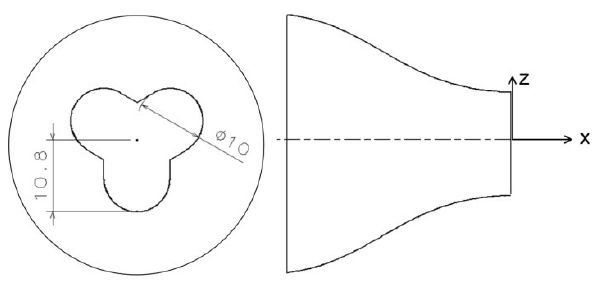
Fig. 1. Nozzle contraction profile and exit geometry .